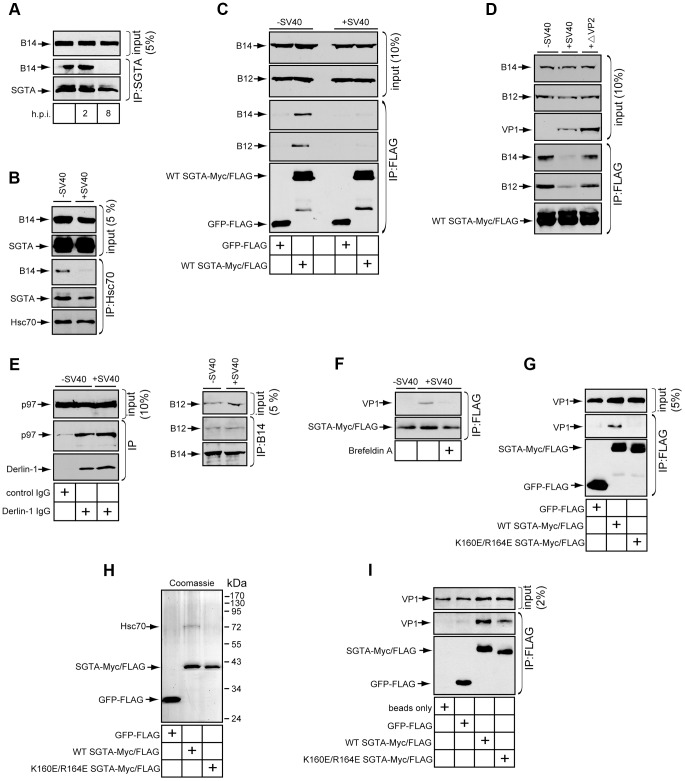
SGTA-Hsc70 dissociates from the B14-B12 complex and engages SV40 during entry.(A) Endogenous SGTA is released from B14 during entry. CV-1 cells were uninfected or infected with SV40 at a high MOI (≈100) for the indicated time. Cells were harvested, cross-linked, and lysed in buffer containing 1% Triton X-100 followed by immunoprecipitation with SGTA antibodies and immunoblotting. (B) Endogenous Hsc70 is released from B14 during entry. CV-1 cells were infected or uninfected for 12 h and immunoprecipitated as in (A) except Hsc70 antibodies were used. (C) Transfected SGTA is released from B14-B12 during entry. CV-1 cells transfected to express FLAG-tagged GFP or SGTA were infected with SV40 for 16 h. Immunoprecipitation was performed without cross-linking and the precipitated material analyzed by immunoblotting. (D) SV40 lacking VP2 fails to trigger dissociation of SGTA from B14-B12. As in (C) except cells were also infected with ΔVP2 SV40. (E) p97-Derlin-1 interaction is unaffected by SV40. Cells infected with virus as in (A) were lysed without cross-linking and immunoprecipitated with the indicated antibodies with subsequent immunoblotting of the precipitated material. (F) SGTA interacts with SV40 in cells during entry. CV-1 cells transfected to express FLAG-tagged WT SGTA were infected with SV40 at high MOI. Where indicated, cells were treated with BFA. Cells were cross-linked, lysed, and immunoprecipitated with anti-FLAG agarose beads. Precipitated proteins were analyzed by immunoblotting with the indicated antibodies. (G) SGTA requires localization to B14-B12 for interaction with SV40. As in (F) except cells were transfected to express either FLAG-tagged GFP, WT SGTA or mutant SGTA. (H) Coomassie staining of purified proteins. (I) Direct binding of SGTA and SV40 in vitro. Purified proteins were incubated with DTT/EGTA-treated SV40. Reactions were cross-linked, and the sampled precipitated using anti-FLAG agarose beads. Bound material was analyzed by immunoblotting.